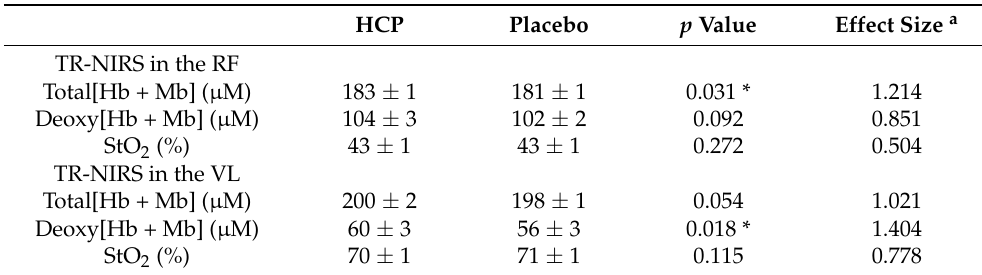
Table 2. Mean values of TR − NIRS profiles in the RF and VL muscles between HCP and Placebo across the 6 peaks of the HIIT protocol.